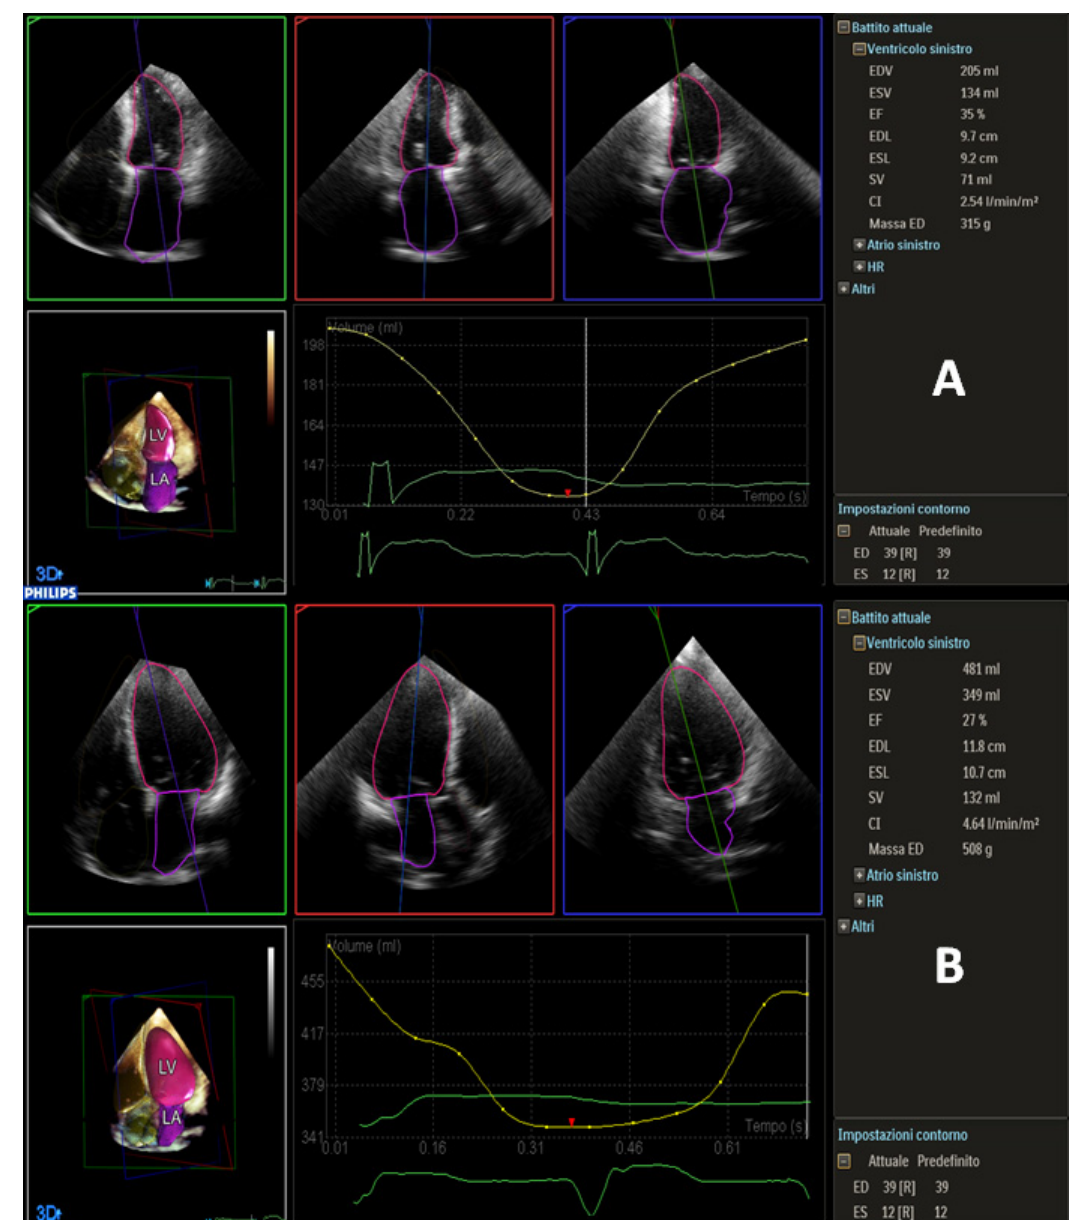
Figure 2. ( A ) Dynamic heart model analysis in D-MR patients, with LVEF of 35% and LVEDV of 205 mL. ( B ) Dynamic heart model analysis in P-MR patient with a severely dilated LV, LVEF of 27% and LVEDV of 480 mL.